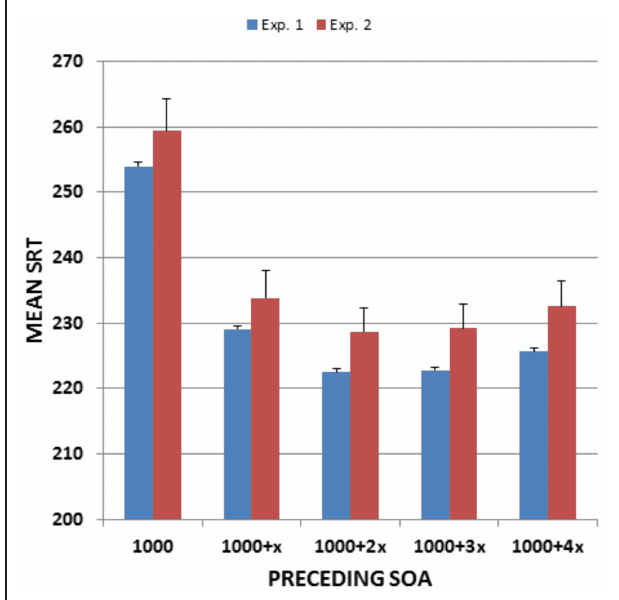
FIGURE 3 | Mean SRTs as a function of preceding SOA. From Experiment 1 and Experiment 2. Error bars show 95% confidence intervals. X , SOA step size (200 ms in Experiment 1 and 250 ms in Experiment